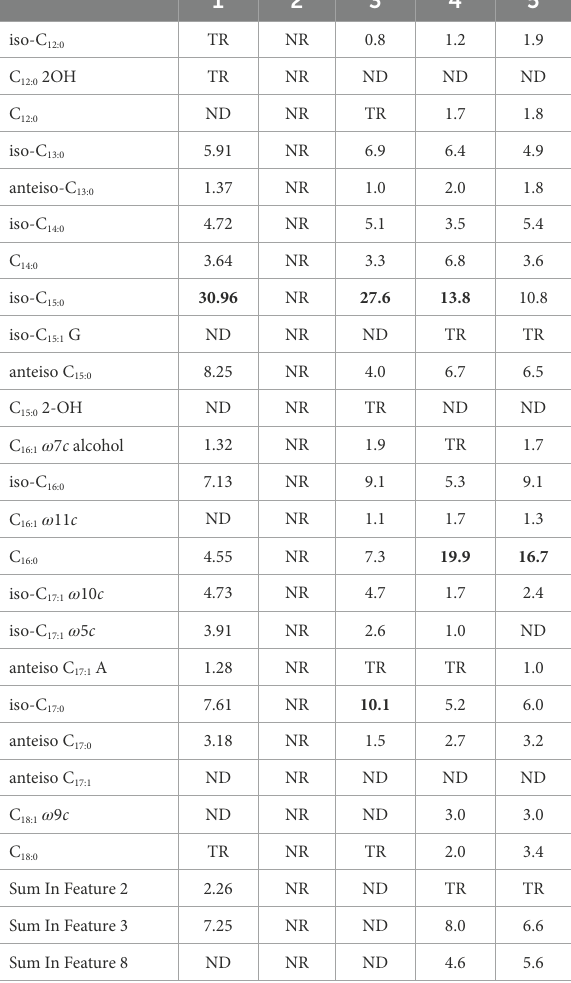
TABLE 7 Cellular fatty acid profiles (> 1%) of strain SAICEU11 T and type strains of closely related species. 1 2 3 4 5